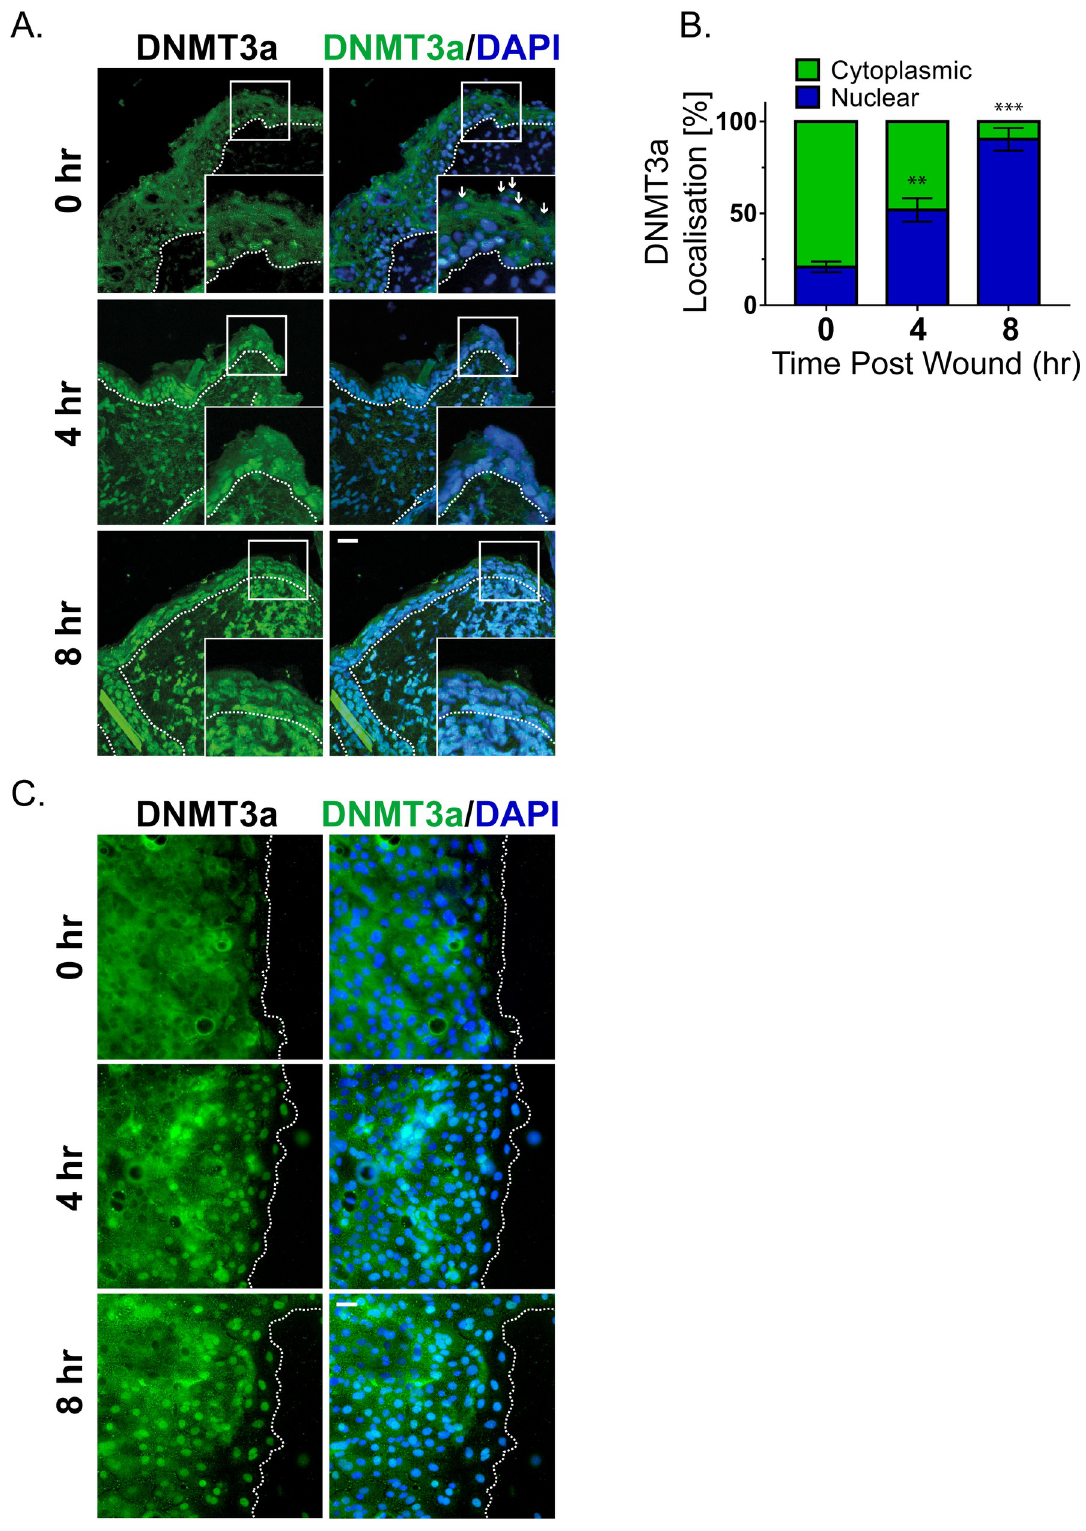
Fig 2. De novo DNMT3a increases nuclear localization at wound proximal site. ( A ) DNMT3a and DAPI staining of wound proximal ( < 0.5 mm) skin sections at different time interval (small white arrows showing nuclei of suprabasal keratinocytes,